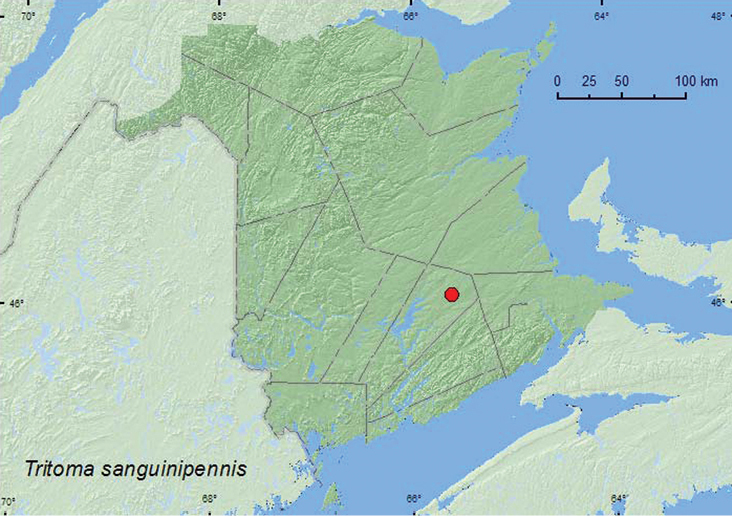
Collection localities in New Brunswick, Canada of Tritoma sanguinipennis.